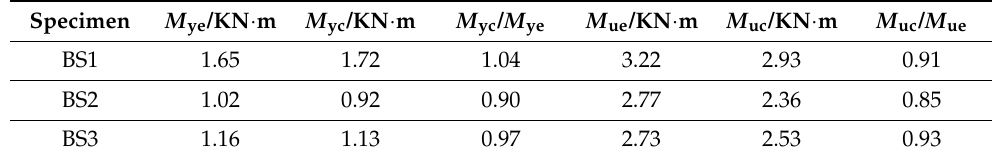
Figure 16. Comparison of experimental versus theoretical moment-rotation curves: ( a ) BS1; ( b ) BS2; ( c ) BS3. Table 3. Comparison analysis.